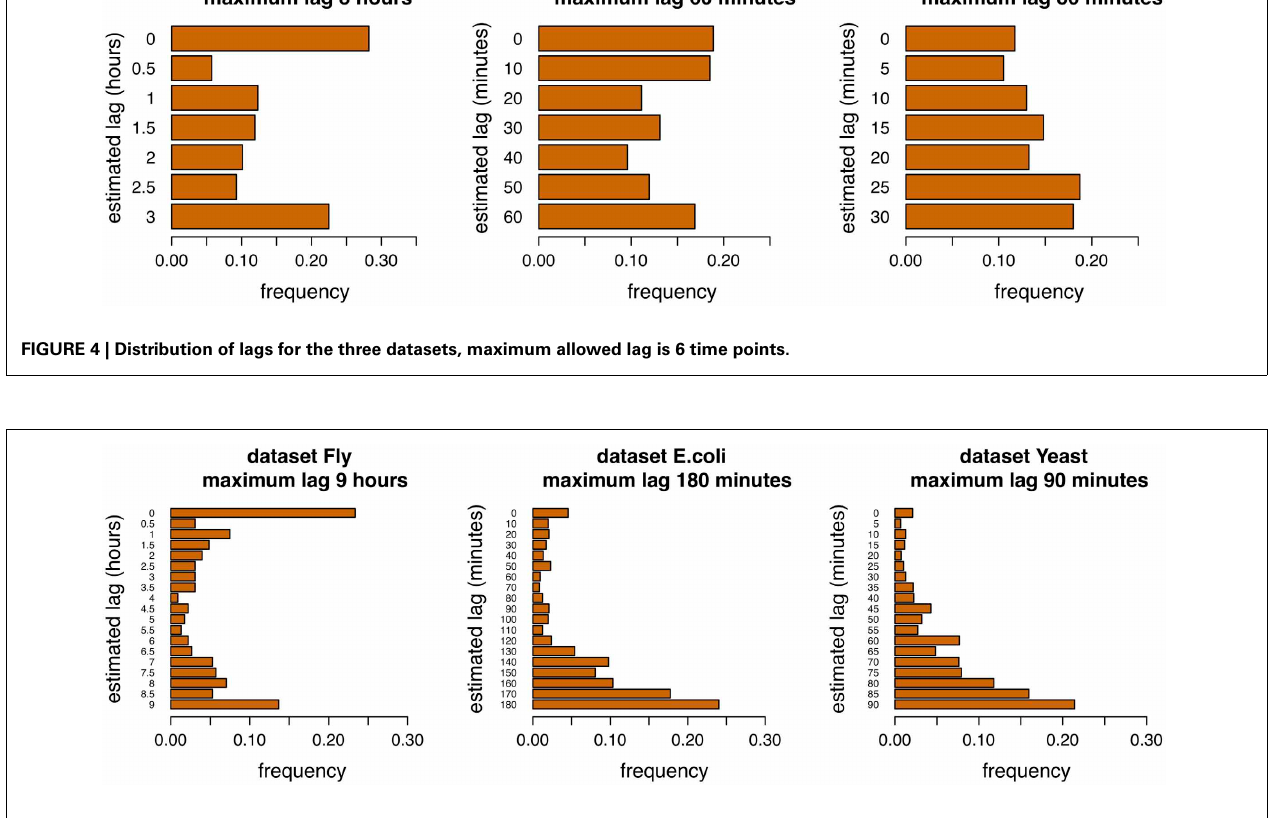
FIGURE 5 | Distribution of lags for the three datasets, maximum allowed lag is 18 time